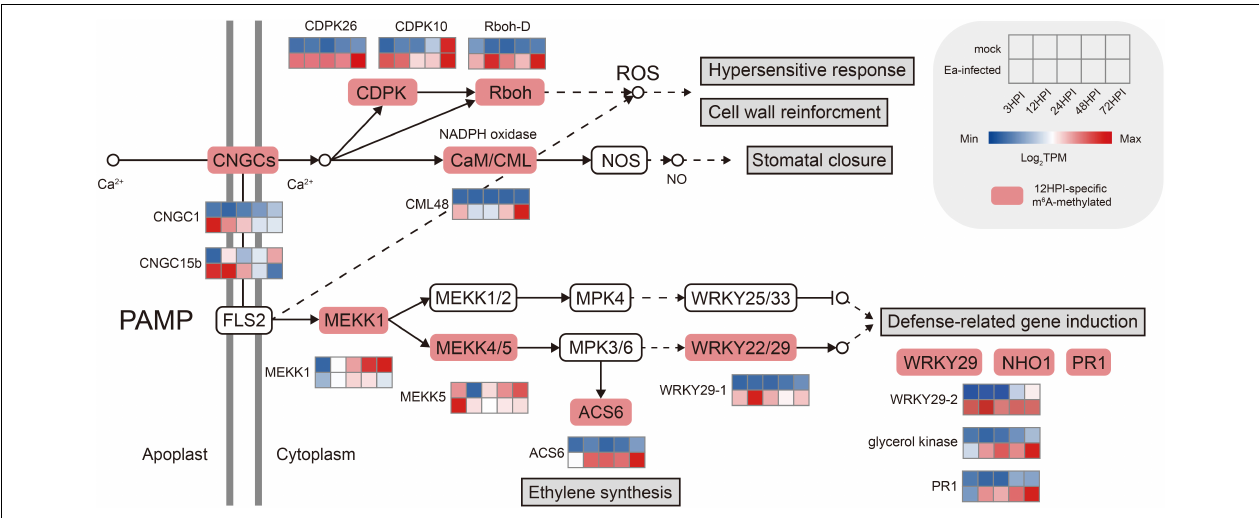
FIGURE 7 | Visualization of pattern-triggered immunity (PTI) after fire blight inoculation. The red boxes indicate 12 HPI–specific m 6 A-methylated genes. The heatmap represents the expression patterns of the mock-inoculated plants and Erwinia amylovora –inoculated plants.